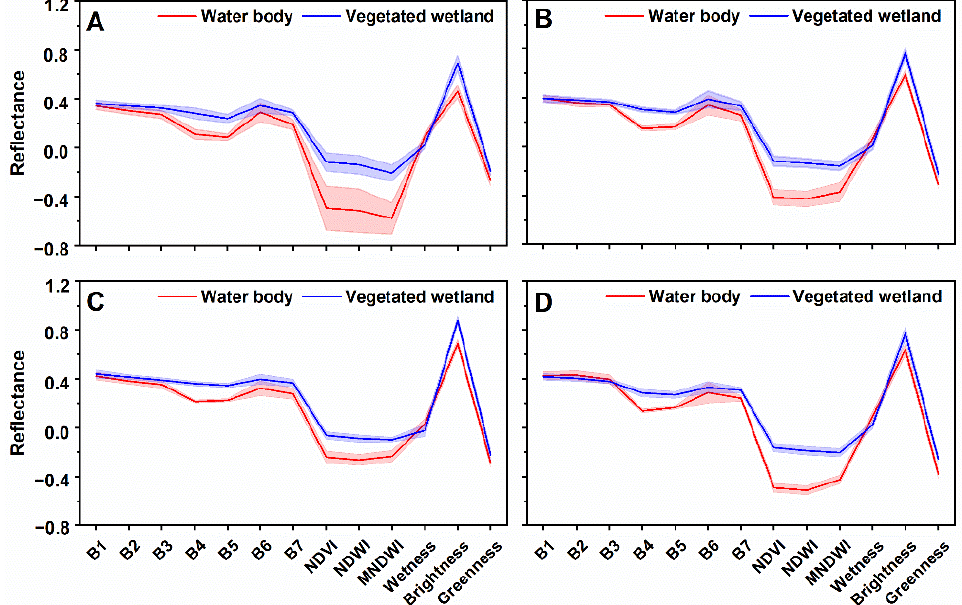
Figure 4. The reference spectral of the water body and vegetated wetland on feature bands . ( A – D ) demonstrate the reference spectral for each type at the four study sites (Site(A – D)).